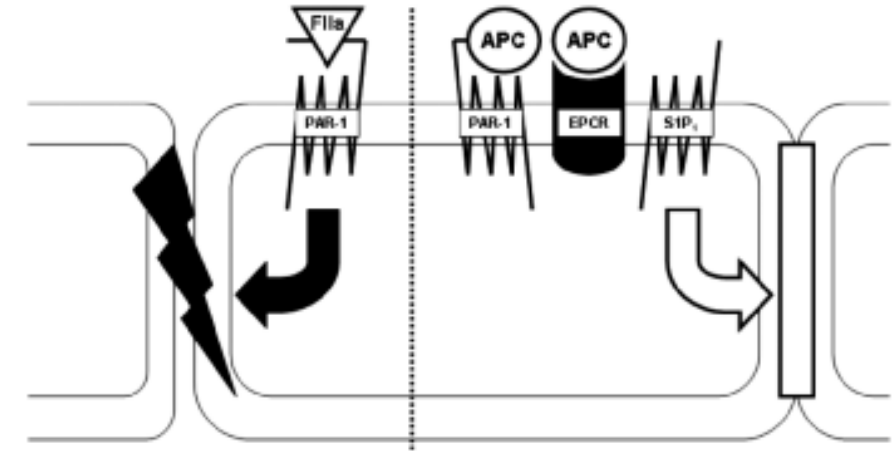
Proposed mecha- nisms of protease- activated receptor (PAR)-1 mediated regulation of vascu- lar integrity. Throm- bin (FIIa) disrupts the vascular barrier by PAR-1 cleavage (left). Activated protein C (APC) binds to the endothelial protein C receptor (EPCR) and has barrier protective effects either by di- rect sphingosine 1-phosphate recep- tor-1 (S1P1) cross- activation or indi- rectly via PAR-1 (right). Models are as proposed in [55,